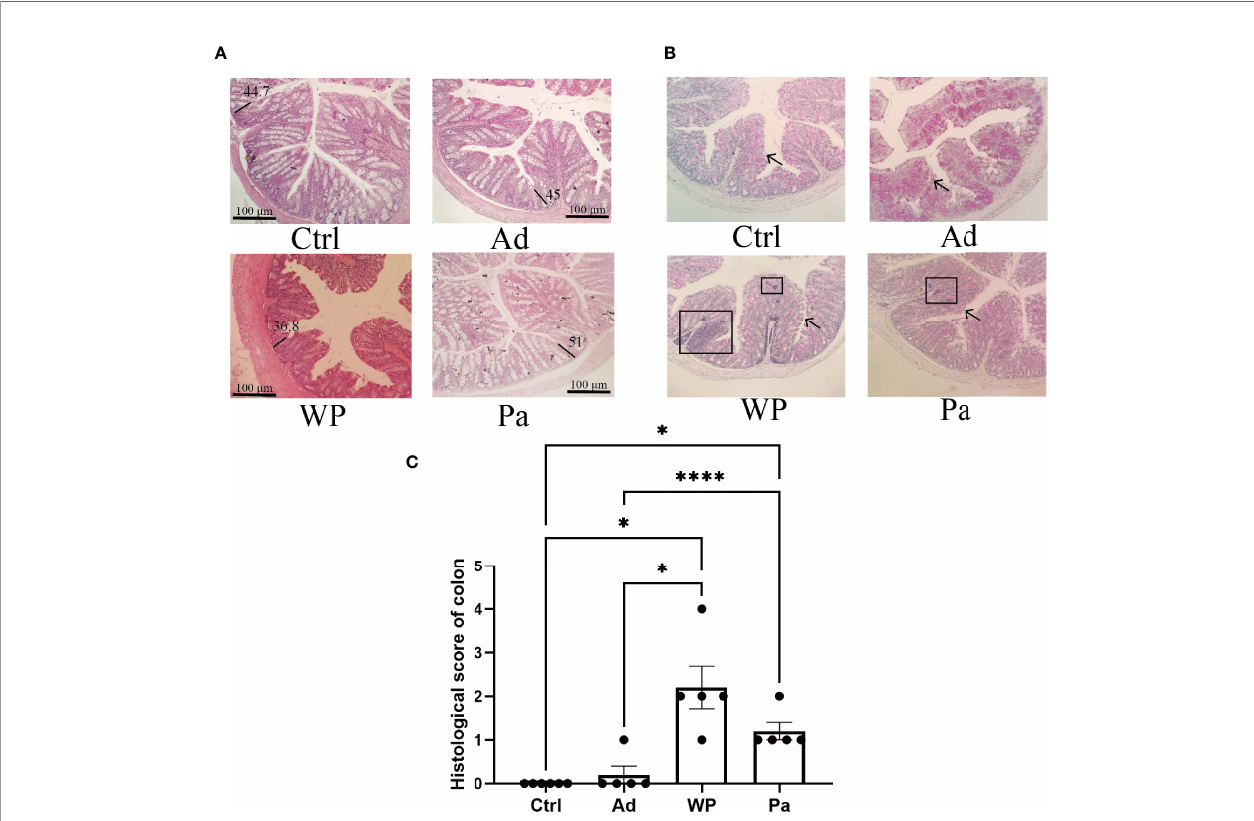
FIGURE 3 | (A) Hematoxylin and eosin-stained colon in non-immunized negative control (Ctrl), group injected with adjuvant (Ad), group injected with gluten and adjuvant (WP), and treated with Pediococcus acidilactici XZ31 (Pa). (B) Periodic acid – Schiff-stained colon in Ctrl, Ad, WP, and Pa. (C) Histological analysis of the colon. n = at least 5 mice per group. The results are presented as the mean value ± standard error of mean. The asterisk indicates a statistically signi fi cant difference ( P <0.05). The stained gut sections were photographed with a Leica microscope at ×100 magni fi cation. The black line represents the crypt depth ( m m). The black box indicates in fi ltration of in fl ammatory cells. The black arrows indicate goblet cells (red